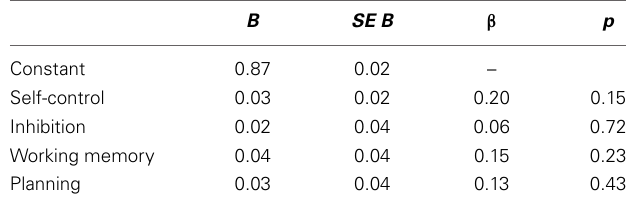
Table 5 | Summary of standard multiple regression analysis for the executive functions processes predicting utterance